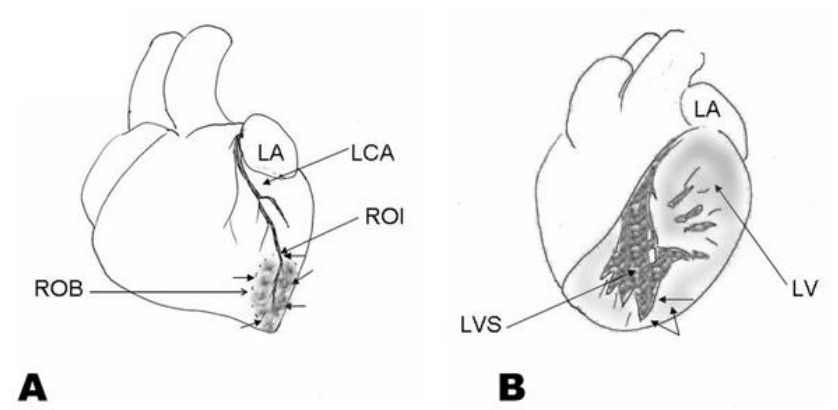
FIGURE 2 . (A) Diagram showing the site of occlusion and of transplant. (B) Cutaway of left ventricle indicating regions sampled for histology. LA, left atrium; LCA, left coronary artery; ROI, region of infarct; ROB, region of blanching. Small arrows, sites of cell injection. (B) Cutaway of left ventricle. LA, left atrium; LV, left ventricle (muscle sagittal cutaway); LVS, left ventricular space. Small arrows, regions sectioned for